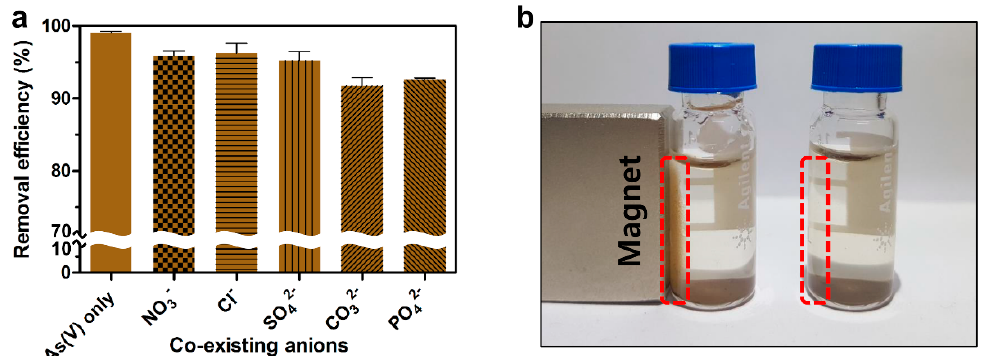
Figure 7. ( a ) Effect of co-existing anion on the removal efficiency. Experimental condition: initial pH = 3, biomass = 0.25 g/L, contact time = 16 h, initial concentration of As(V) = 50 mg/L. Initial concentration of co-existing anions: NO 3 − = 10 mg/L, Cl − = 200 mg/L, SO 42 − = 200 mg/L, CO 32 − = 50 mg/L, PO 43 − = 50 mg/L. All experiments were performed in triplicate; error bars denote standard deviation. ( b ) Recovery of DR-FeNPs-As(V) by